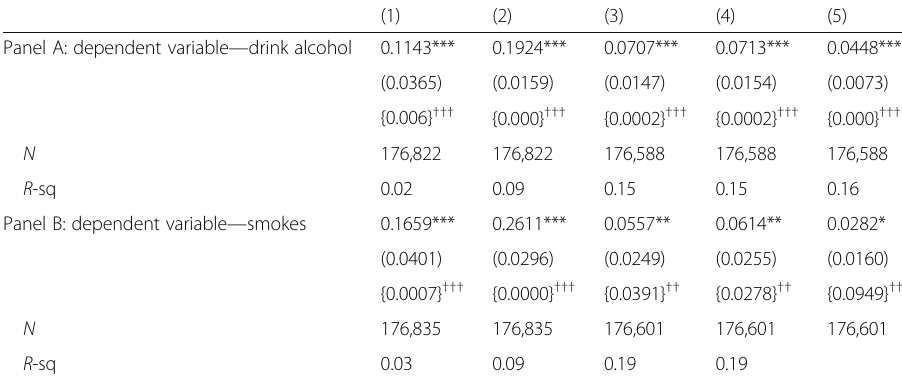
Table 3 The effect of MLDA on drinking and smoking (sample: all men 15 – 50 years old) Panel A: dependent variable — drink